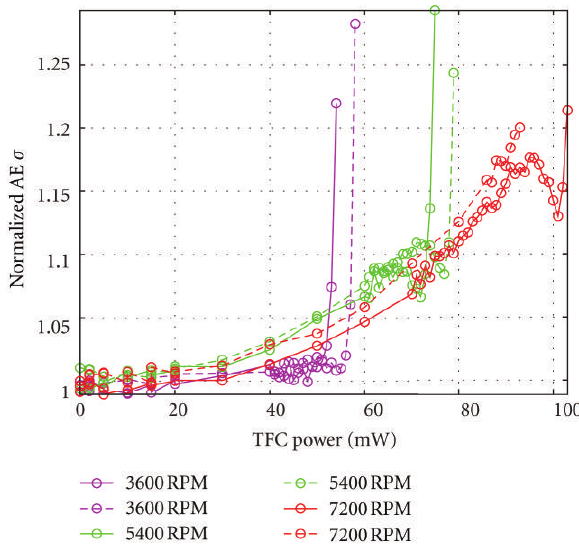
Figure 4: Touchdown plots for ABS-2 at di ff erent disk RPM (dashed lines for a burnished slider).